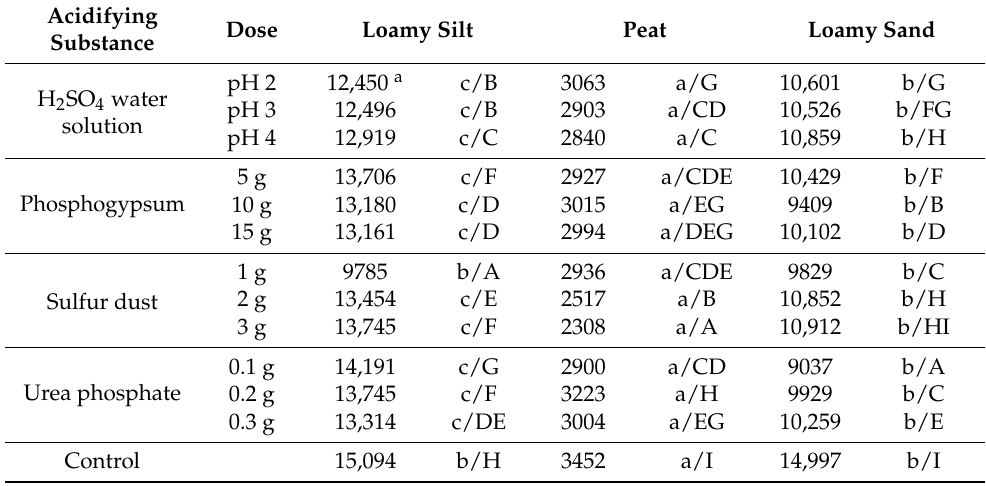
Table 8. Effects of acidifying substances after 12 months on the content of available iron in loamy silt, peat and loamy sand (mg/kg).